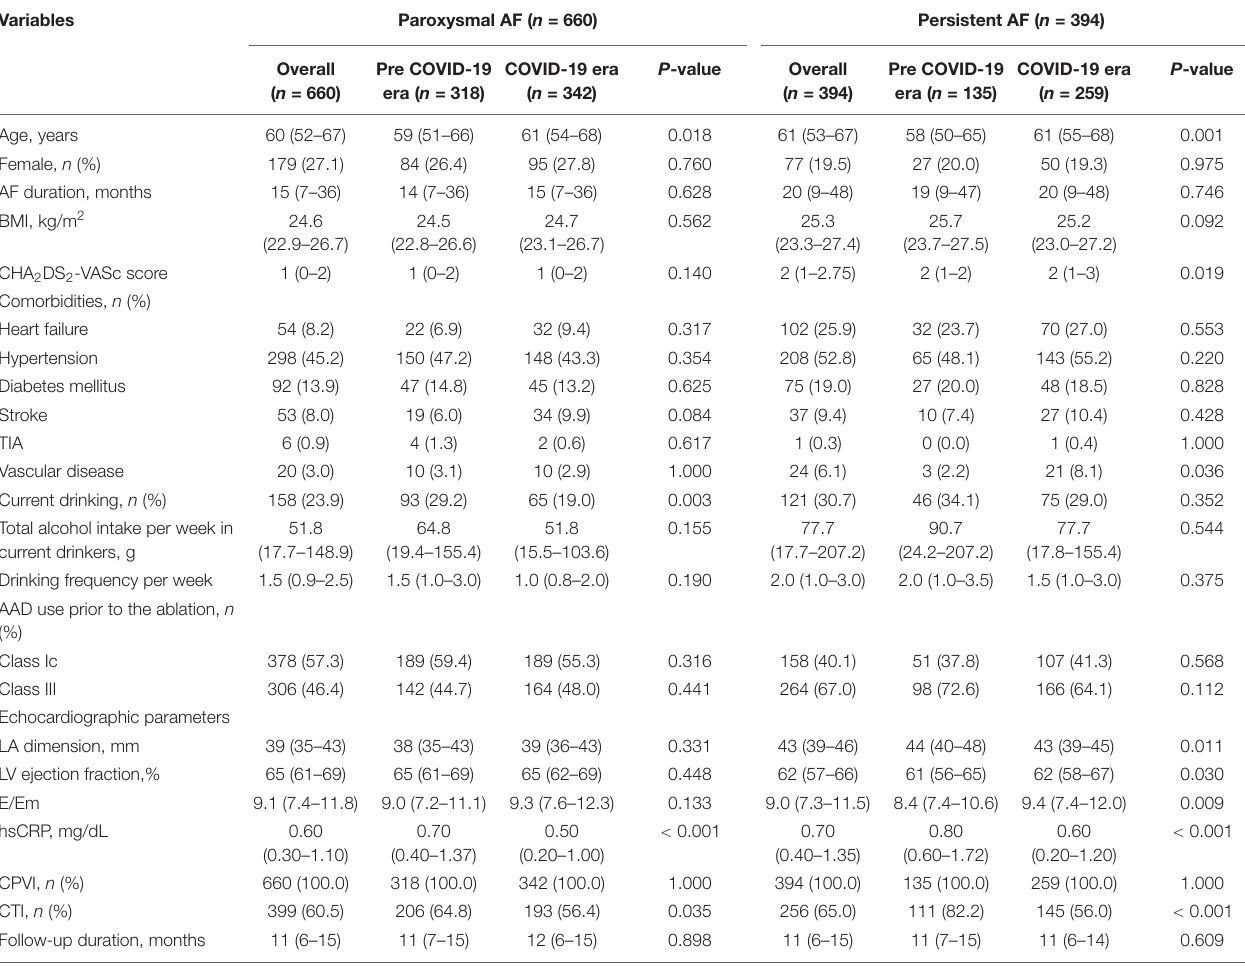
TABLE 1 | Baseline characteristics of patients with paroxysmal and persistent atrial fibrillation undergoing catheter ablation.